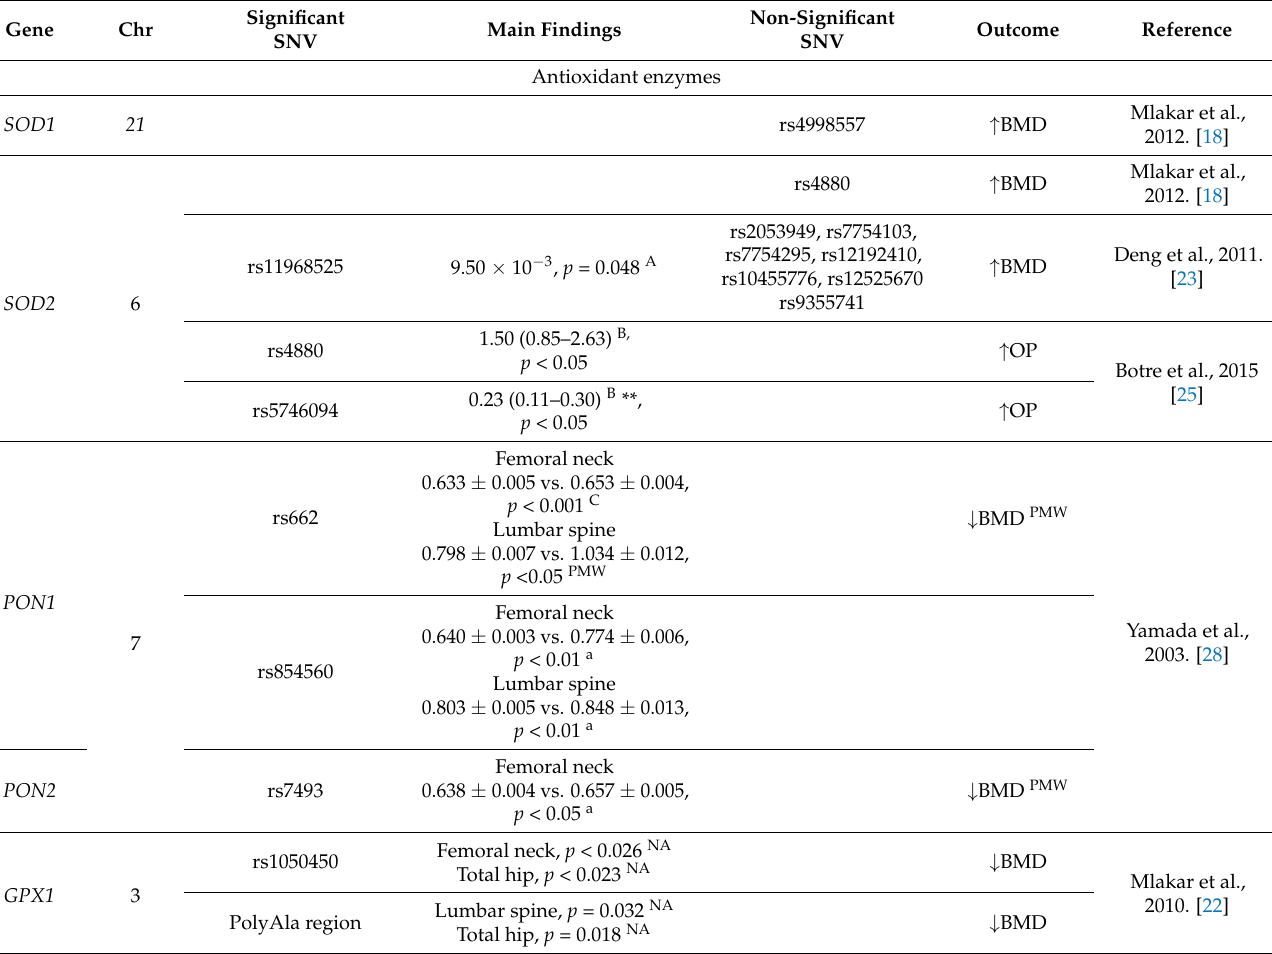
Table 2. Polymorphisms related to oxidative stress, BMD, and osteoporosis